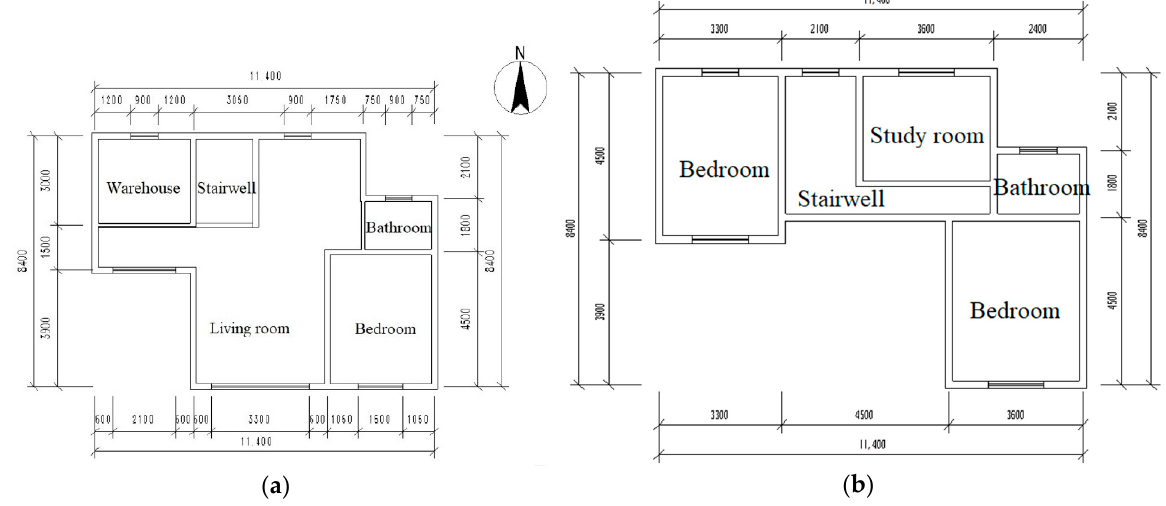
Figure 1. Layout of the research building object: ( a ) first floor and ( b ) second floor.